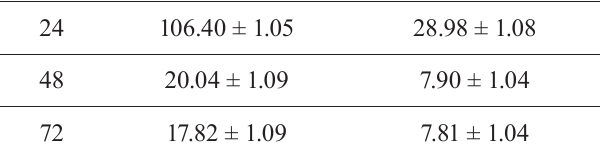
TABLE I - I C values obtained at 24th, 48th and 72th hours 50 after new compound applied MTT test performed in A549- Luc and SKOV3-Luc cell